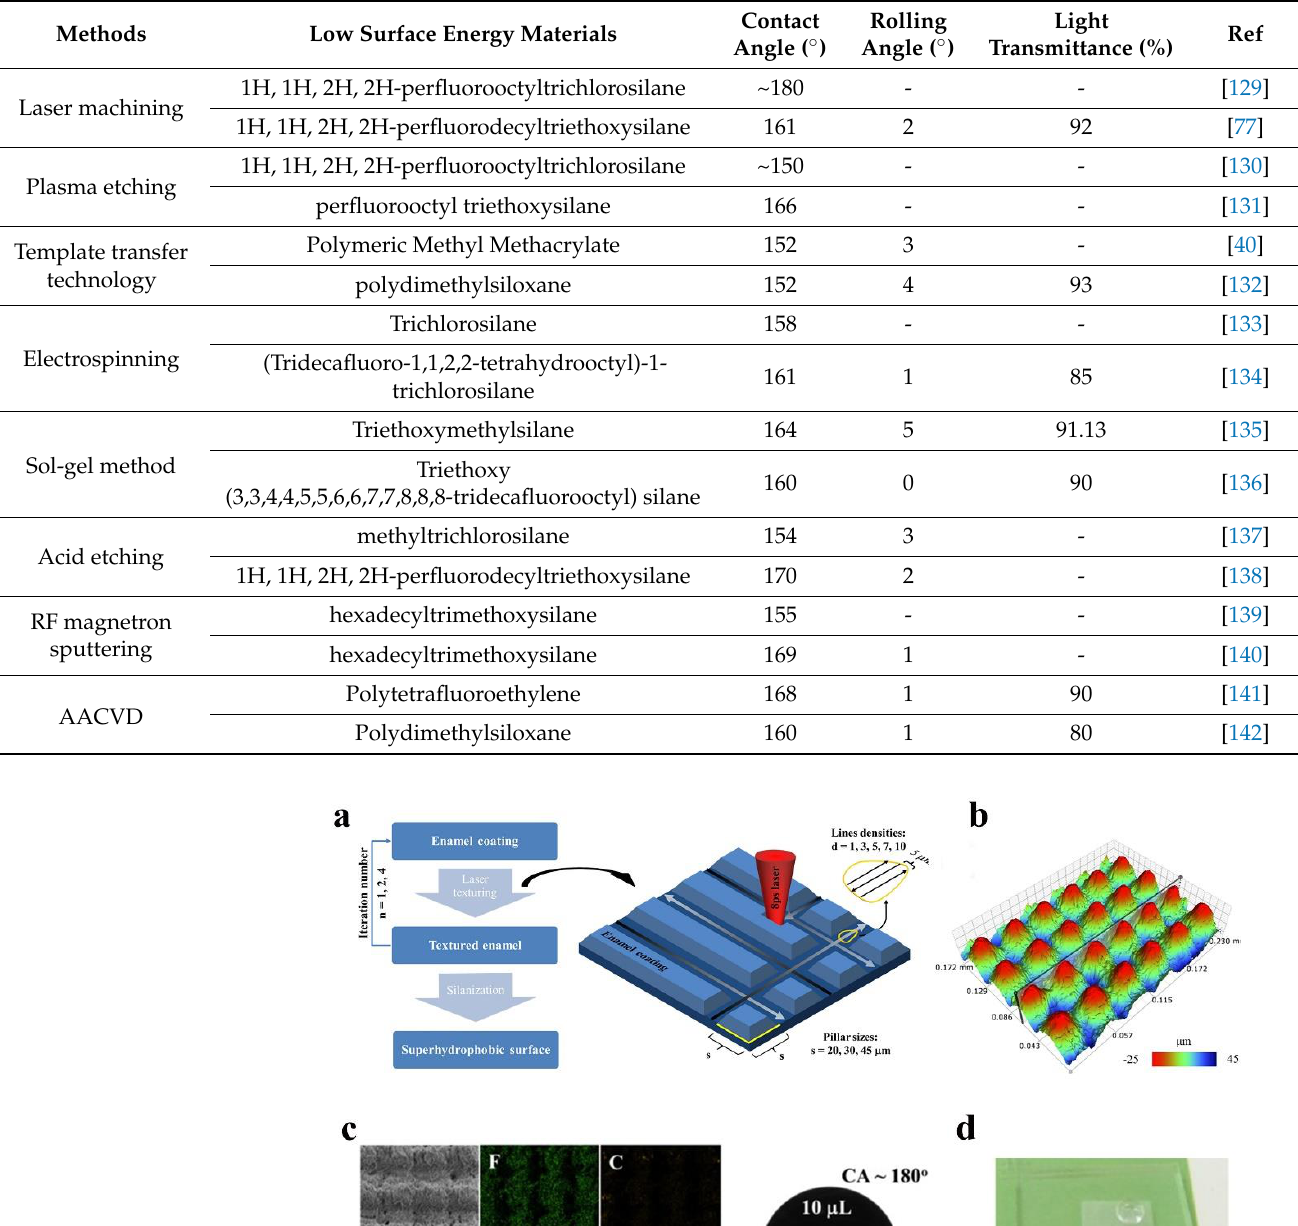
Table 2. Summary of methods for constructing superhydrophobicity.